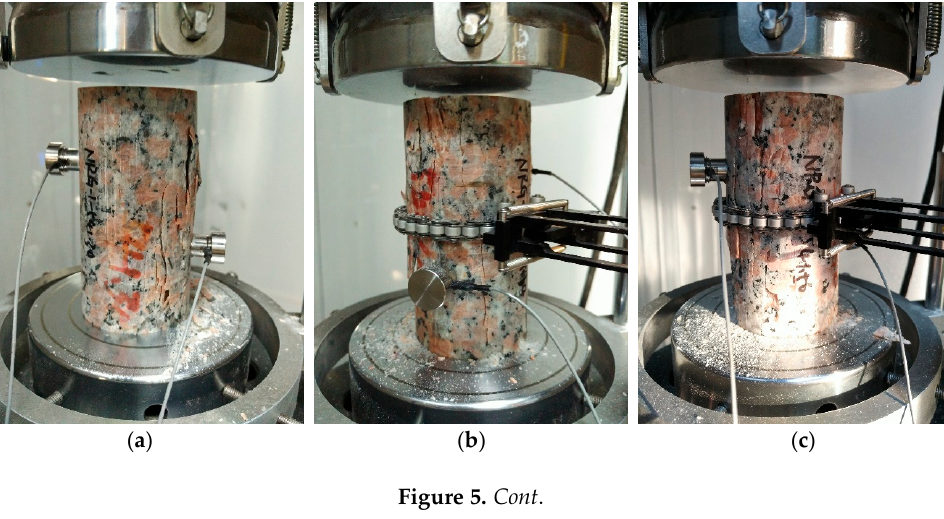
Figure 4. The curves of axial stress versus deformation of different specimens under UCS and UTS testing. ( a ) The stress–strain curves under UCS testing; ( b ) The curves of axial stress versus axial deformation under UTS testing.